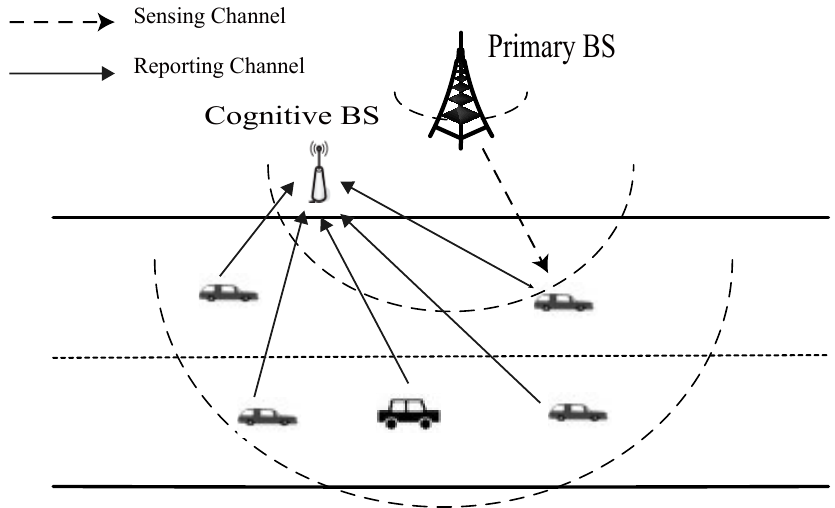
Figure 1. An illustrative example of cooperative sensing operation for cognitive vehicular networks. There is a PU, a cognitive BS and multiple cooperative SVUs over wireless sensing/reporting